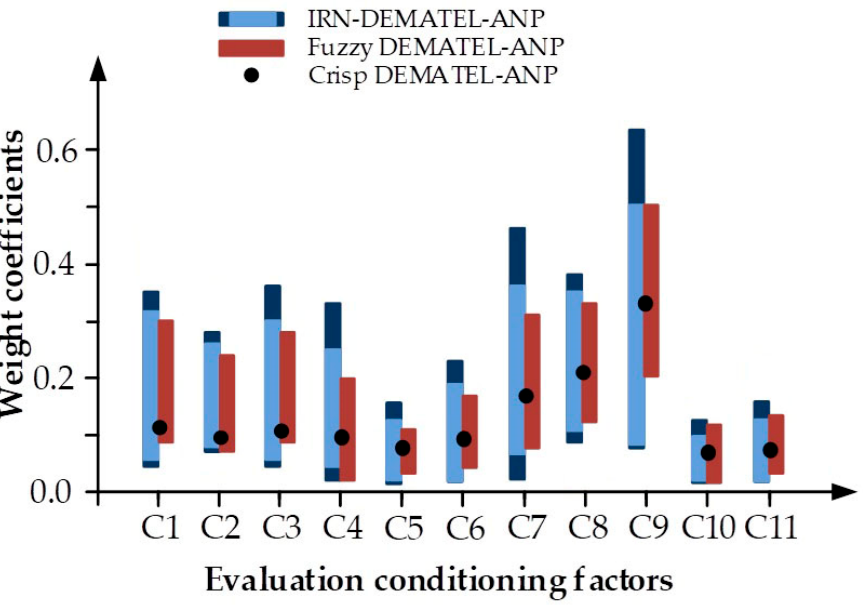
Figure 6. Comparison of the conditioning factors weighting.